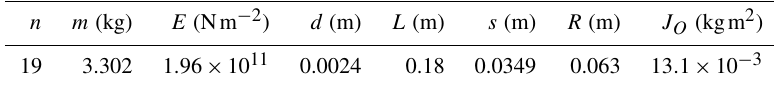
Table 1. The structure parameters of the vibration damper. n m